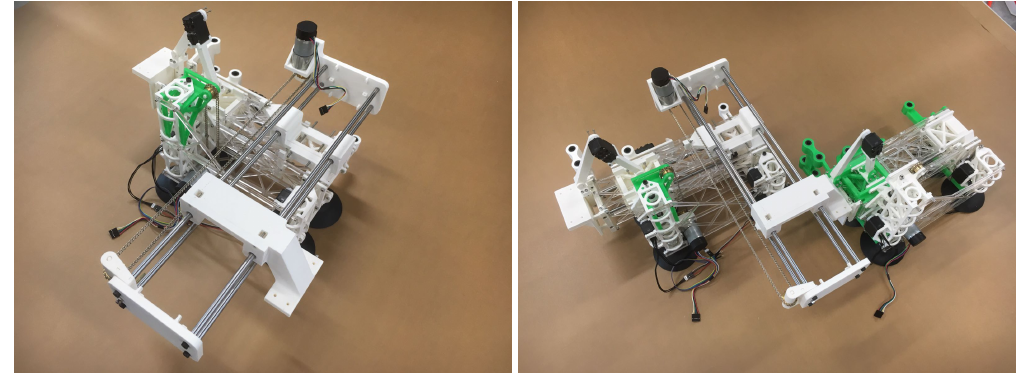
Figure 8. The fabricated module prototype ( Left ). The platform of the nested reconfigurable façade cleaning robot after assembling two modules ( Right